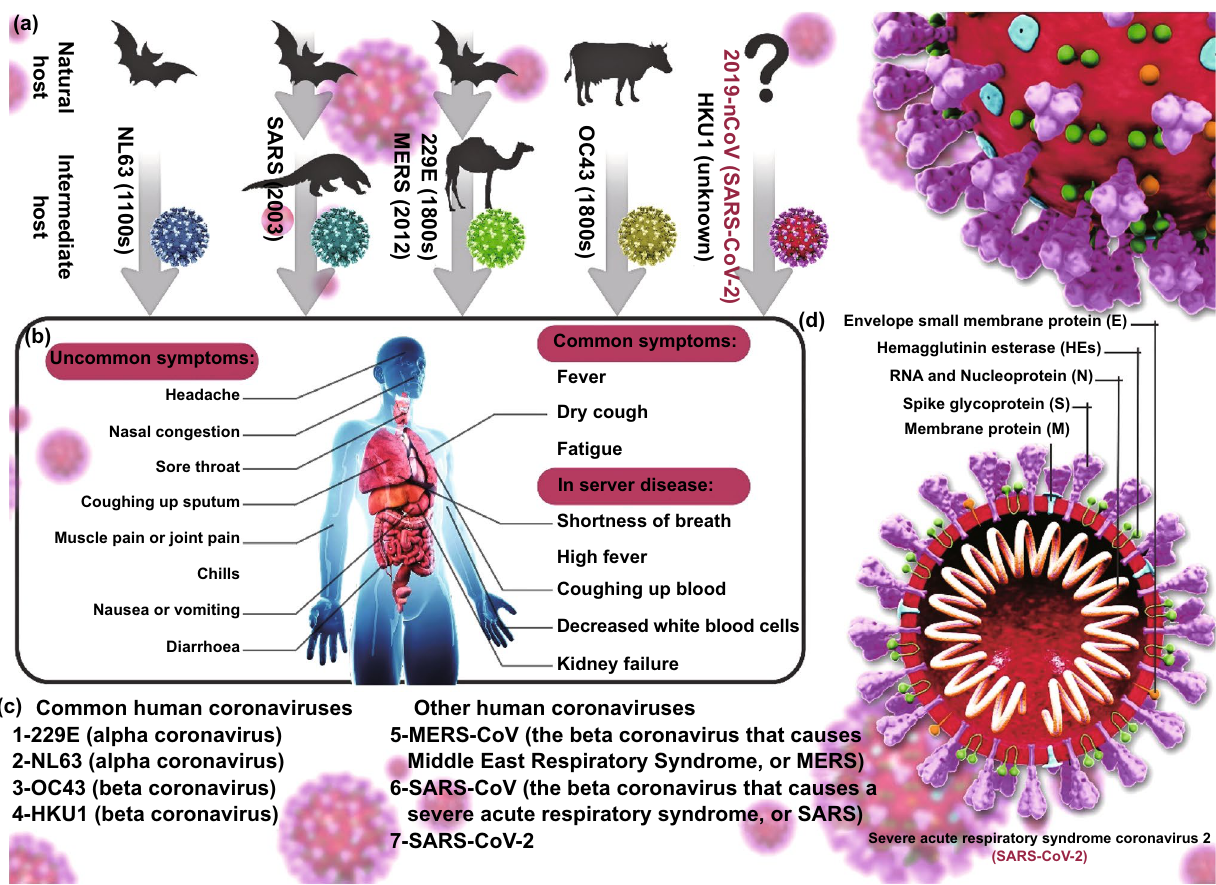
Fig. 2 a Animal (natural and intermediate hosts) origin of human coronaviruses; b clinical presentation of patients with SARS‑CoV‑2 including common, uncommon, and severe symptoms of SARS‑CoV‑2. c Human coronavirus types: common human coronaviruses; 229E (alpha corona‑ virus), NL63 (alpha coronavirus), OC43 (beta coronavirus), HKU1 (beta coronavirus), and other human coronaviruses; MERS‑CoV (the beta coronavirus that causes Middle East Respiratory Syndrome, or MERS), SARS‑CoV (the beta coronavirus that causes the severe acute respira‑ tory syndrome, or SARS), SARS‑CoV‑2 (the novel coronavirus that causes coronavirus disease 2019, or COVID‑19); d diagram of coronavirus virion structure showing genome(ranges from 26 to 32 kilobases, the largest for an RNA virus) and structural proteins: spike (S), envelope (E), membrane (M), and nucleocapsid (N). N protein forms a complex with RNA and aids in the viral assembly after its replication; S, E, and M proteins create the viral envelope, and S protein is a club‑shaped surface projection, giving the virus its characteristic crown‑like appearance on electron microscopy, which is responsible for viral entry into the human